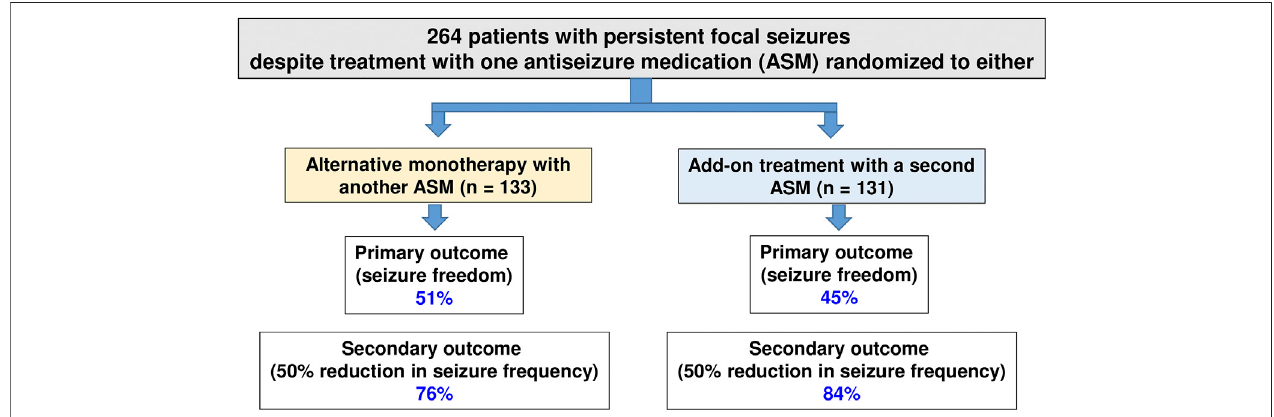
FIGURE 4 | Ef fi cacy of early add-on treatment versus alternative monotherapy in patients with persistent focal seizures despite treatment with one antiseizure medication(ASM),whichwasthe fi rstASMadministeredinthesepatients.AlternativemonotherapyorearlyinitiationofcombinationtherapywithanotherASMresultedin similar ef fi cacy, and the adverse effects associated with monotherapy or polytherapy were similar. Data are from a multicentre, cluster-randomized, prospective, controlled trial in patients with persistent partial seizures despite treatment with one ASM (which was the fi rst ASM in these patients). For details, see Semah et al.